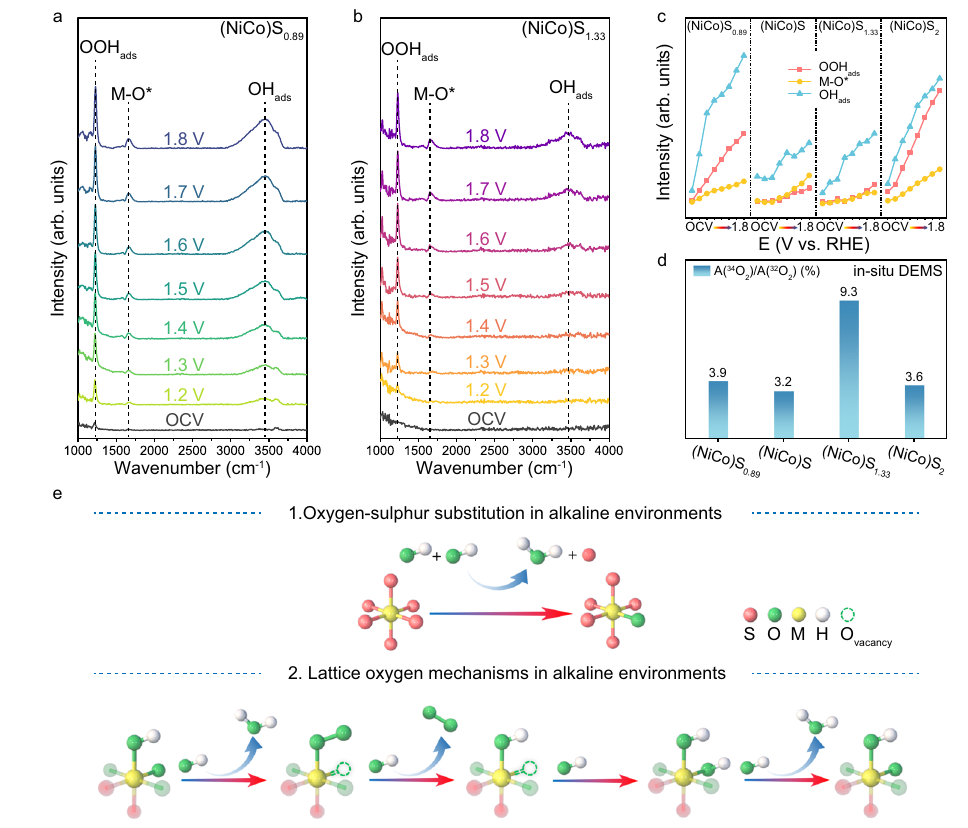
34 O 2 and 32 O 2 of (NiCo)S 0.89 and (NiCo)S 1.33 from the reaction products cycled in H 2 16 O aqueous KOH electrolyte. e Schematic diagram of the lattice oxygen mechanism with lattice sulfur-oxygen substitution